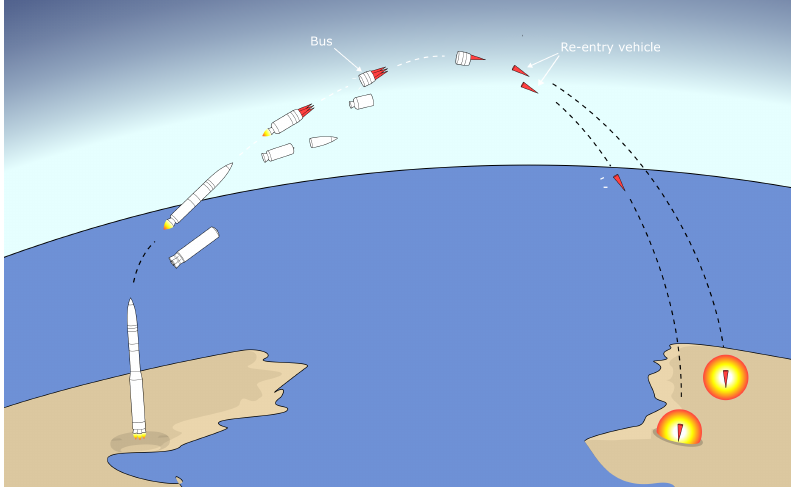
Figure 2. A schematic drawing of the operation of a MIRV.